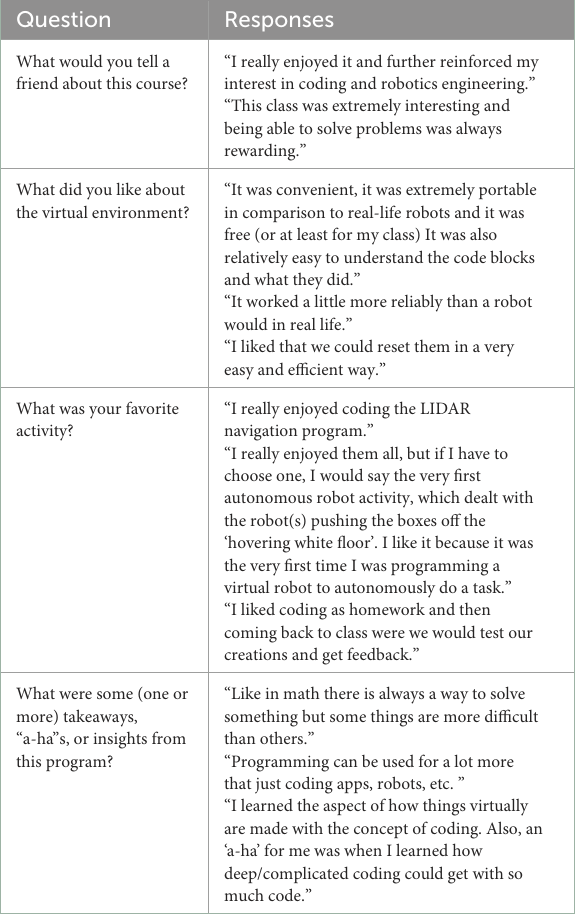
TABLE 4 Pre-test and post-test results, significant ( p < 0.05) column marked with